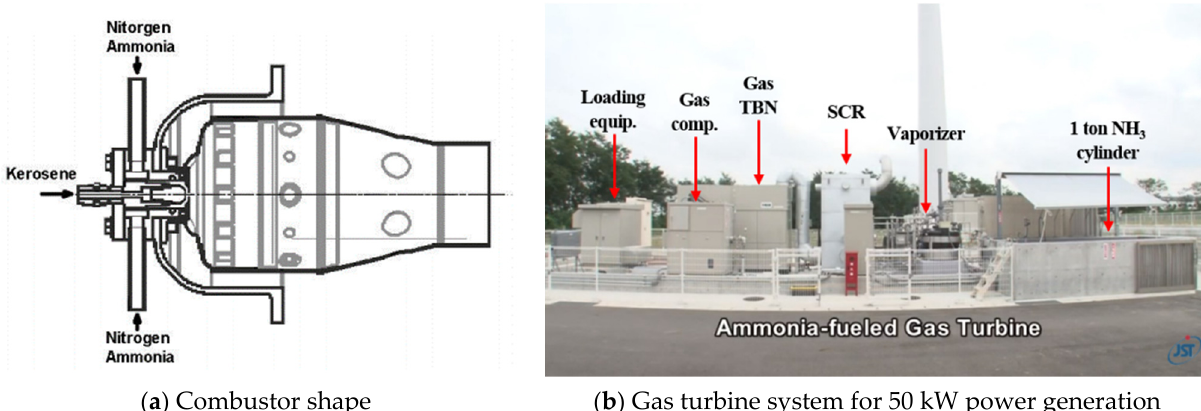
Figure 19. 50 kW class NH 3 burning gas turbine combustor and power generation system: ( a ) NH 3 combustor for prototype bi-fuel combustion; ( b ) Test facilities for micro gas turbine power generation with large amount of NH 3 gas supply (1 ton cylinder). Modified from [101]. Courtesy of Ammonia Energy Association [101].